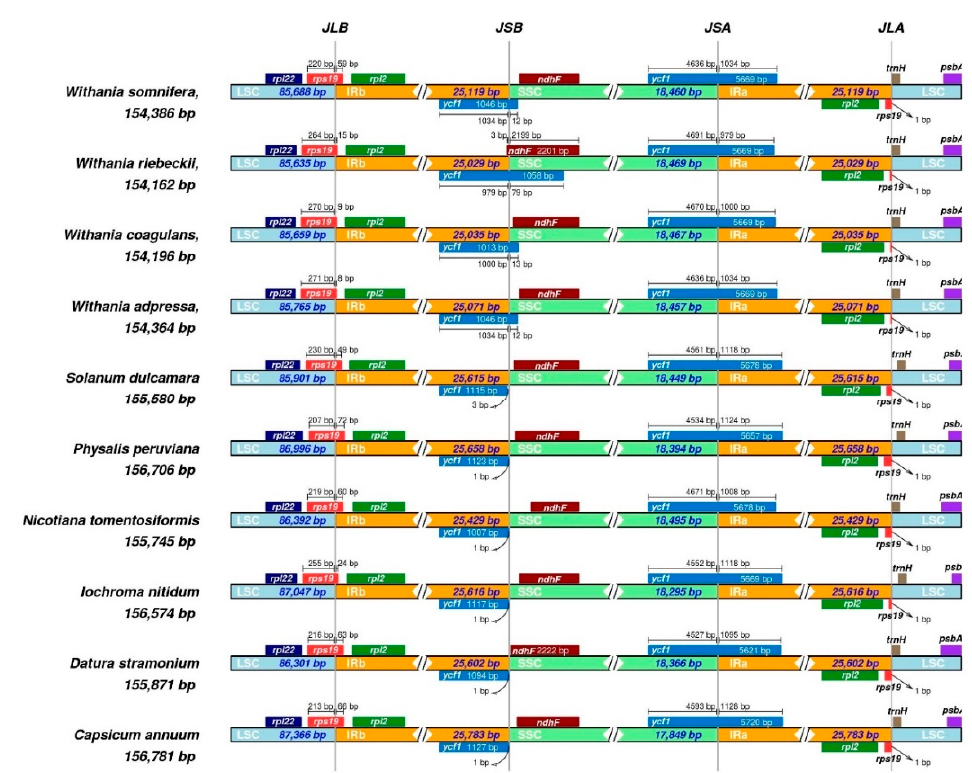
Figure 8. The comparative assessment of junction sites among six Withania species and six outgroups of Solanaceae. Genes are represented by boxes above (negative-strand) and below (positive-strand) the proportionate line. The size of each gene and their relative position at the junctions are shown in base pairs (bp). The figure shows the conservation of the junctions among Withania species with mild shifts at the JSB (IRb/SSC).